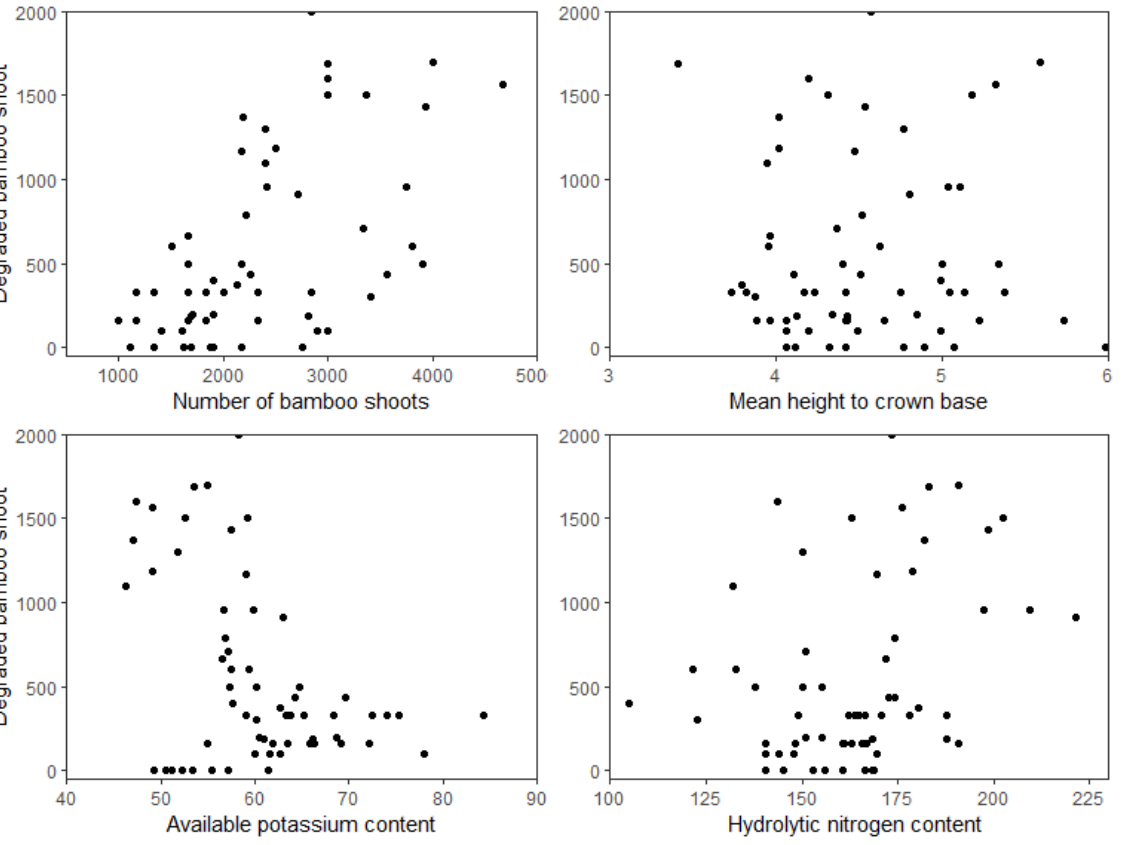
Figure 4. Scatter plot distribution between degraded bamboo shoots (DBS) and different predictor variables used for modeling DBS for moso bamboo (number of bamboo shoots (NBS), mean height to crown base (MHCB), hydrolytic nitrogen (HN), and available potassium (AK)). In practice, the matrix form of the NLME is as follows.